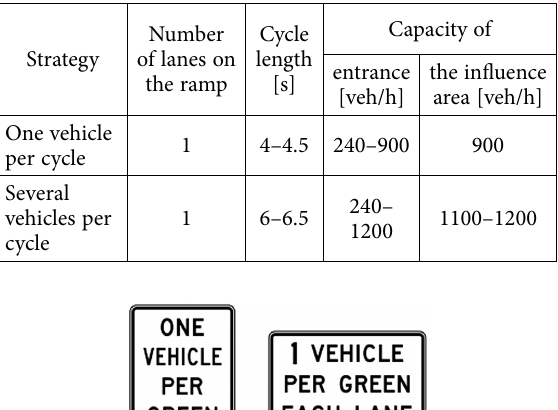
Table 2. Access Control Management (ACM) strategies Number Strategy of lanes